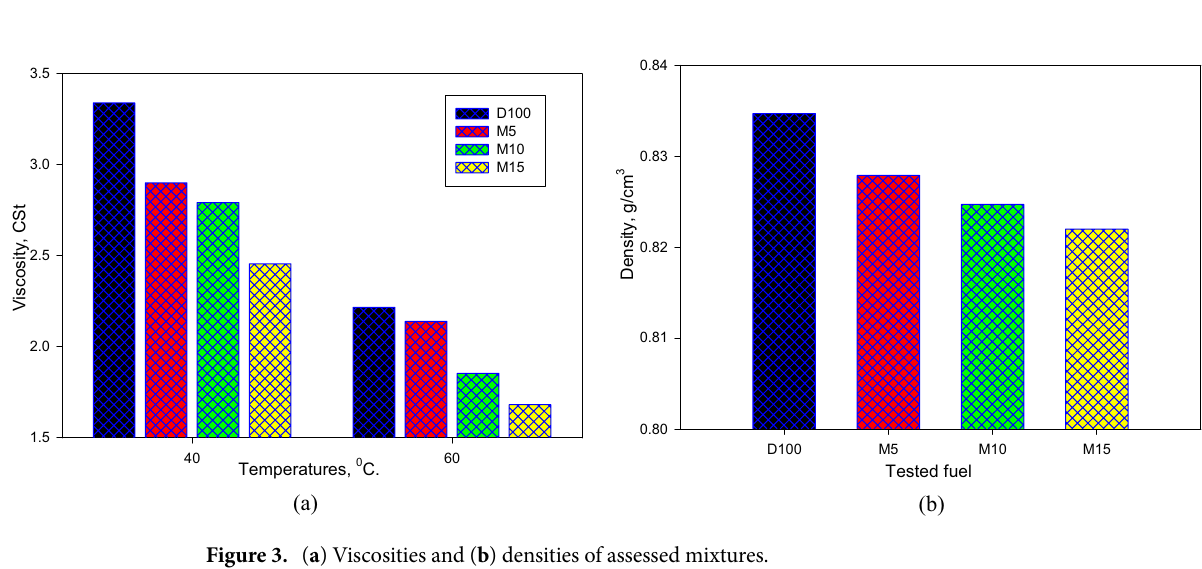
Figure 3. ( a ) Viscosities and ( b ) densities of assessed